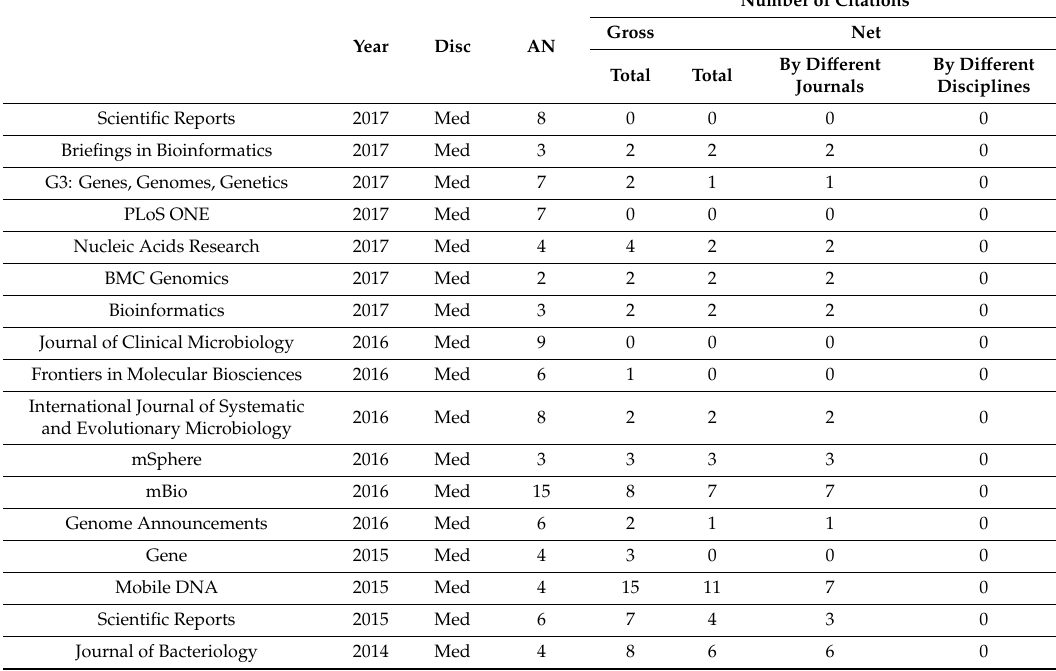
Table A6. Descriptive statistics and Scopus categories for the randomly selected PH analyzed for the health sciences. Each row represents a single publication; multiple publications in the same journal and same year are represented by separate